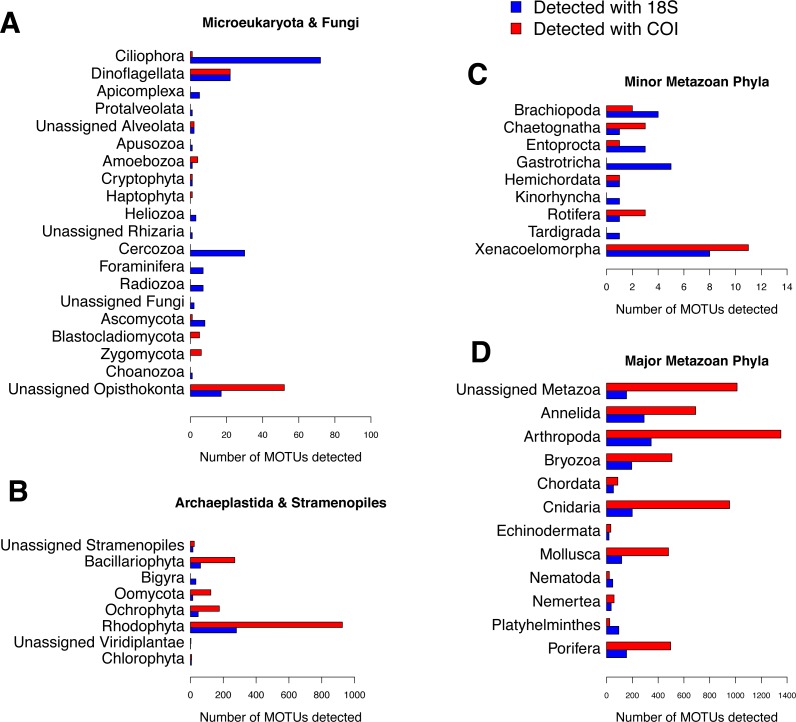
Number of MOTUs detected for every phylum in the studied communities using 18S (blue) or COI (red).Note the different scales used for (A) microeukaryota and Fungi, (B) Archaeplastida and Stramenopiles, (C) minor metazoan phyla, and (D) major metazoan phyla.